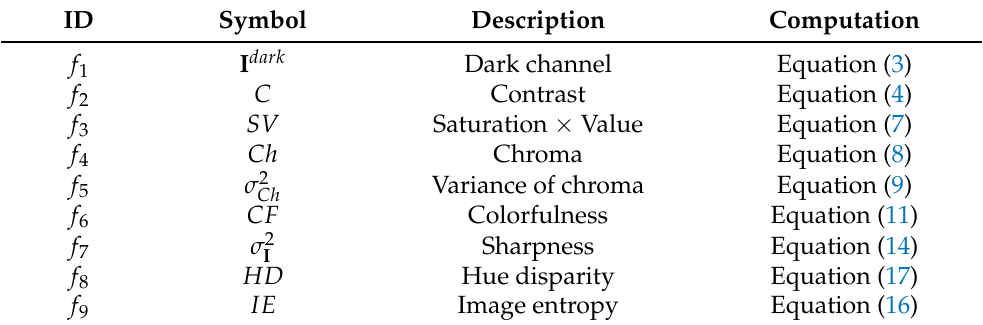
Figure 5. The absolute values of the Pearson correlation coefficients between haze-relevant features. Table 2. A summary of haze-relevant features. ID stands for feature